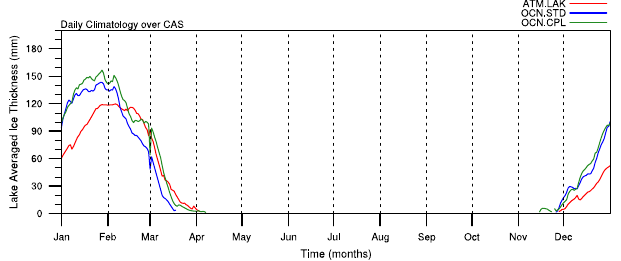
Fig. 18. Time series of daily sea ice climatology of OCN.STD and OCN.CPL simulations and observation (ARCLAKE) for the period